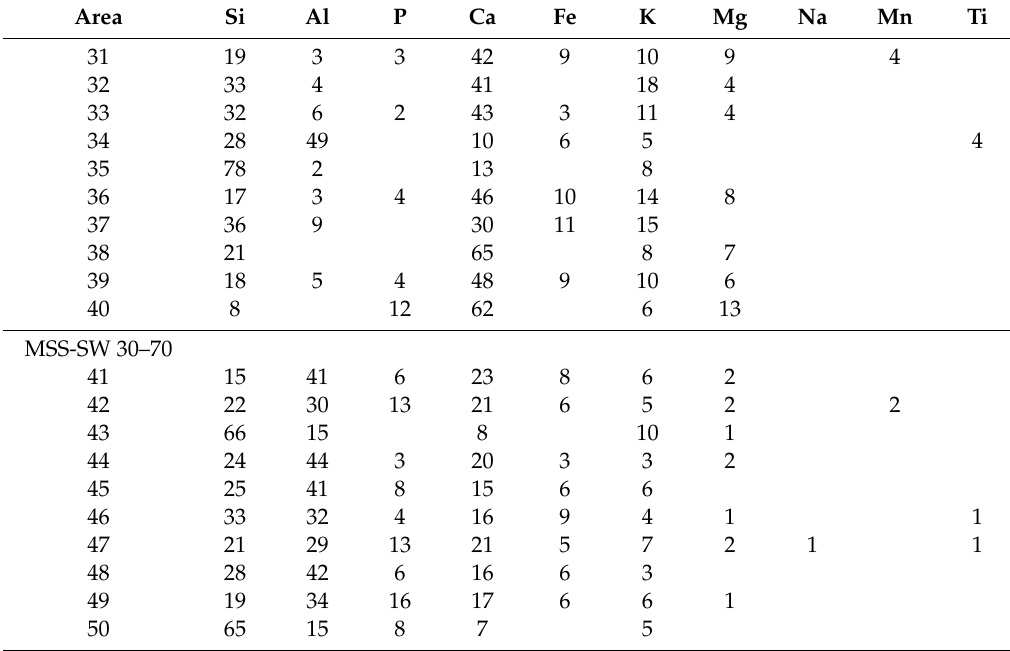
Table 8. Element distribution in marked areas in Figure 7 given as wt.% on carbon and oxygen free basis.